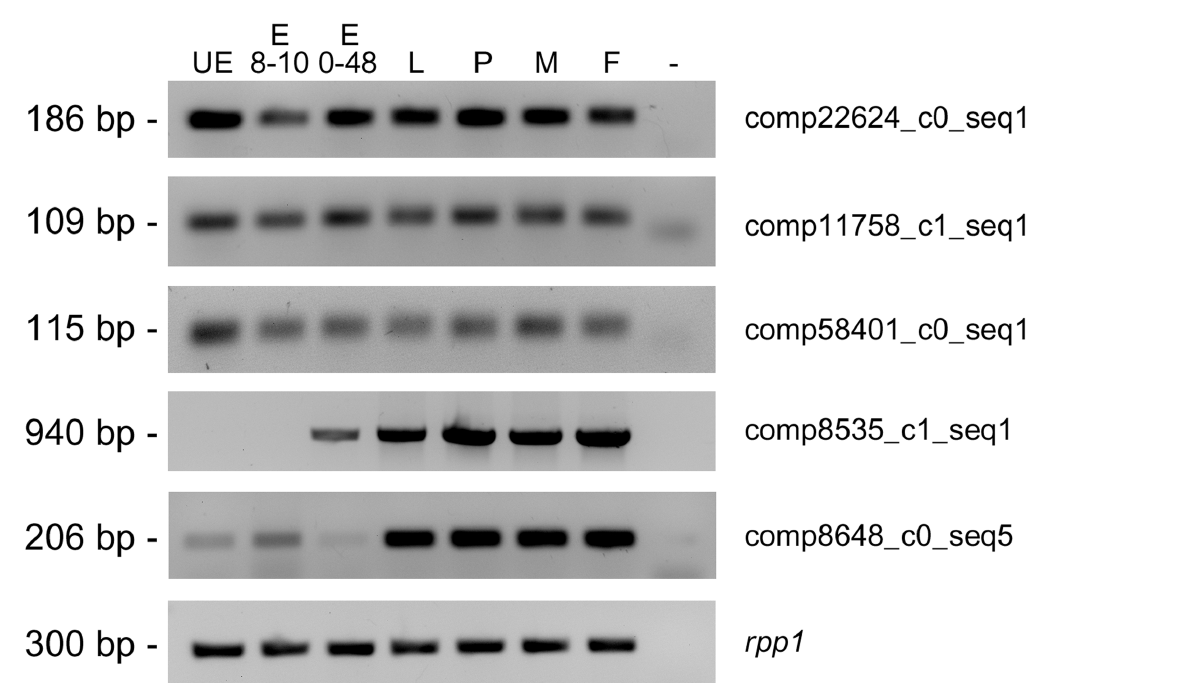
Figure 5. Temporal expression analysis of putative non-coding RNAs. UE 5 unfertilized eggs; E8–10 h 5 embryos at the stage of 8–10 hours after egg laying (AEL); E0–48 h 5 embryos at the stage of 0–48 hours AEL; L 5 third instar larvae; P 5 pupae; M 5 adult males; F 5 adult females. All the samples constituted individuals of both